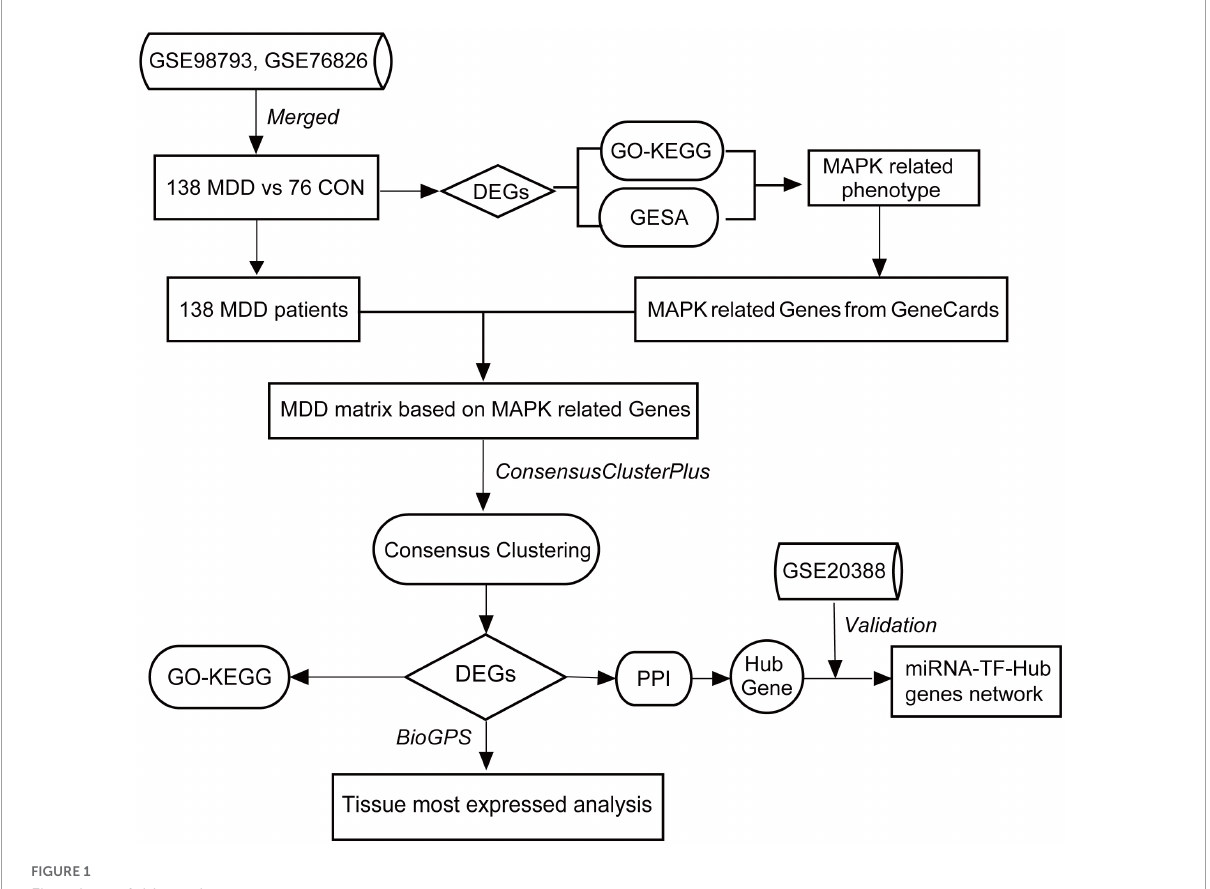
FIGURE1 Flowchart of this